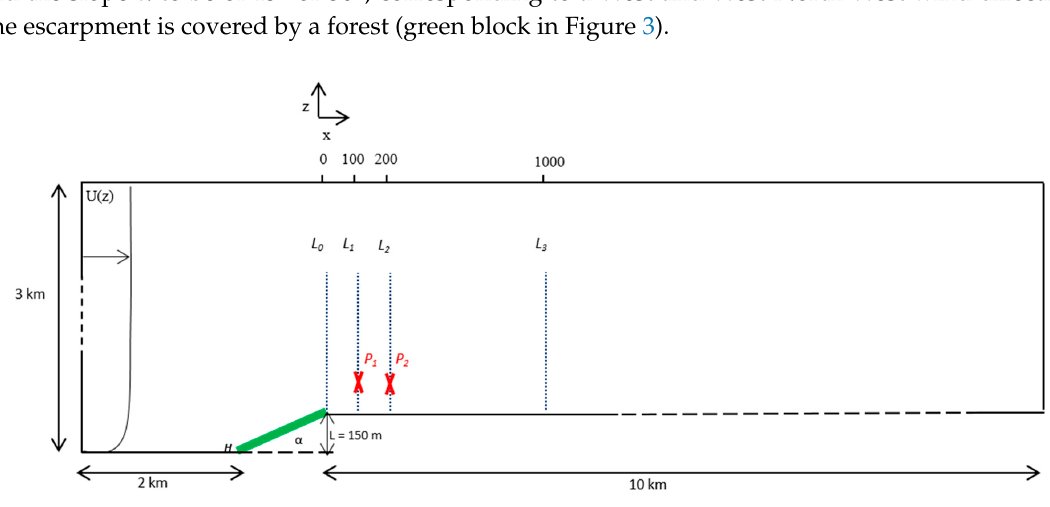
Figure 3. 2D geometry for the DoE study and the location of lines L 0 , L 1 , L 2 and L 3 , situated 0 m, 100 m, 200 m, and 1000 m downstream of the forested escarpment (green block), respectively.